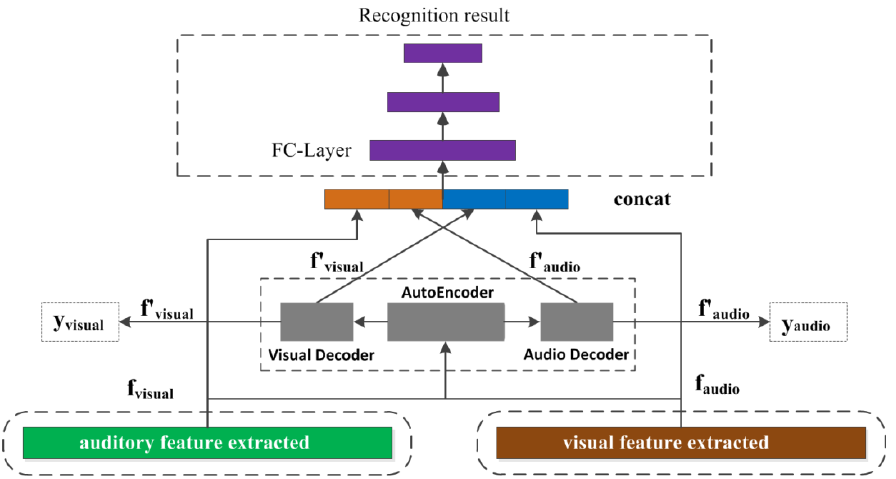
Figure 4. Violence recognition network based on auditory visual fusion of Autoencoder mapping.